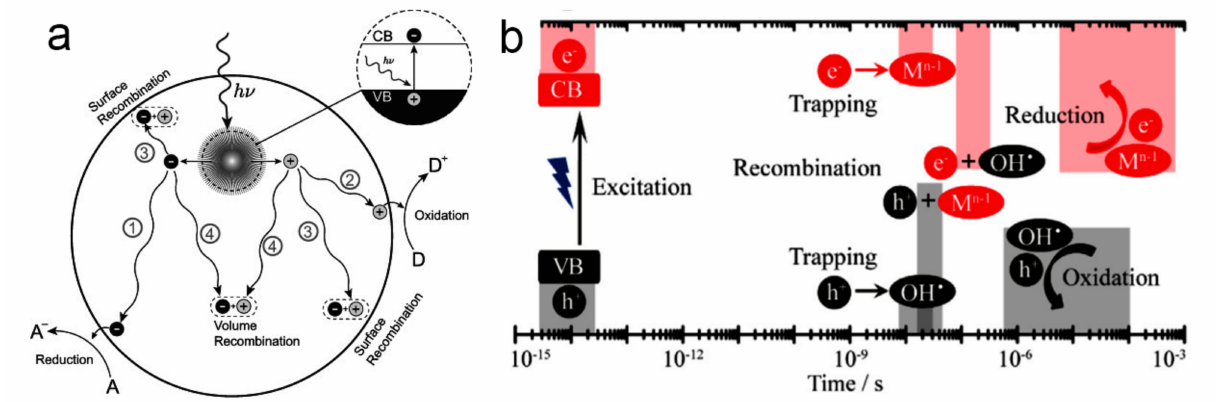
Figure 1. ( a ) A general principle of photocatalysis and elementary steps involved in photocatalytic reactions starting from light absorbance and generation of electron-hole pairs to some of the de- excitation pathways for the electrons and holes. Adapted with permission from Ref. [61]. ( b ) A typical time scale for elementary steps in photocatalysis. Adapted with permission from Ref.